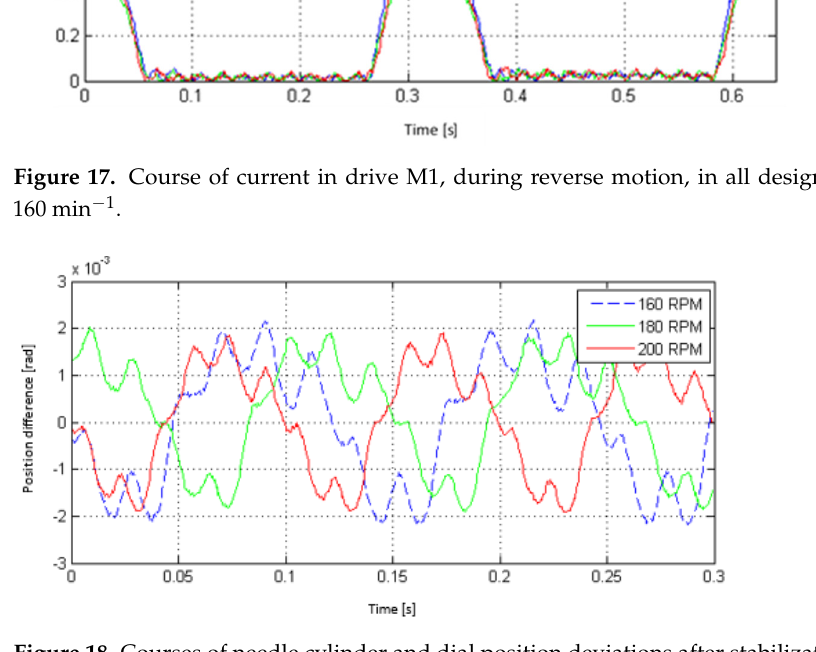
Figure 17. Course of current in drive M1, during reverse motion, in all designs at a velocity of 160 min − 1 .